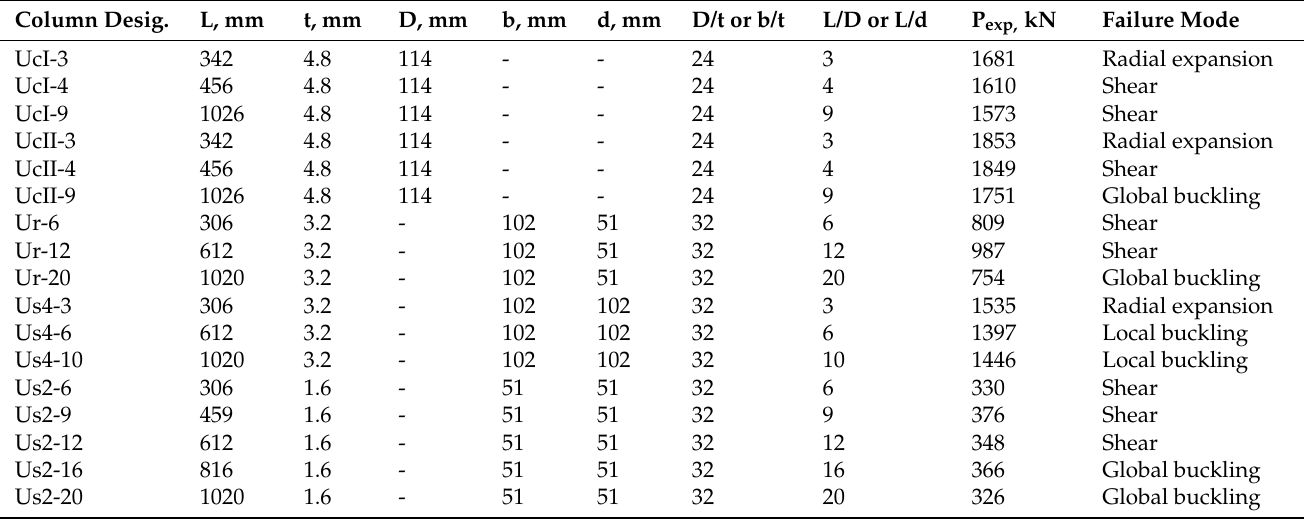
Table 1. Geometric dimension and designations of CFST columns with test